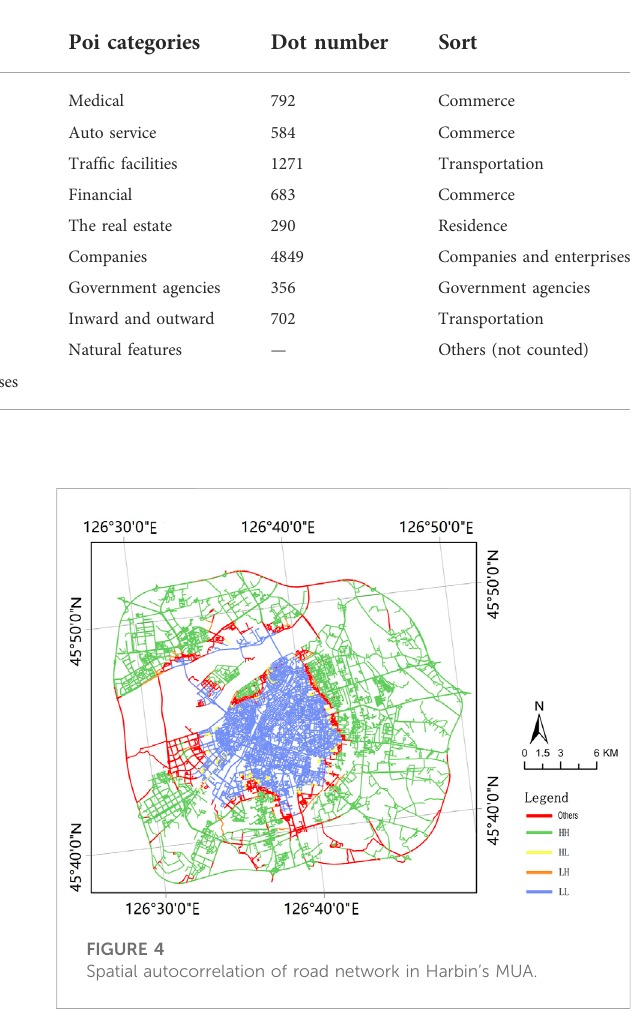
TABLE 1 Infrastructure data classi fi cation.